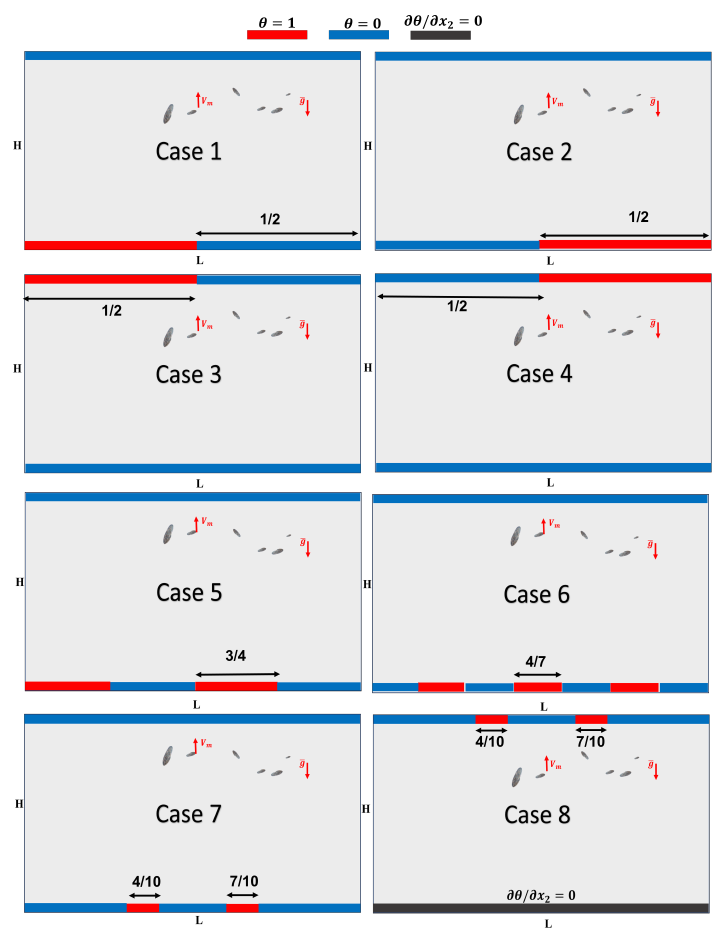
Figure 1. Different heating conditions analyzed in this